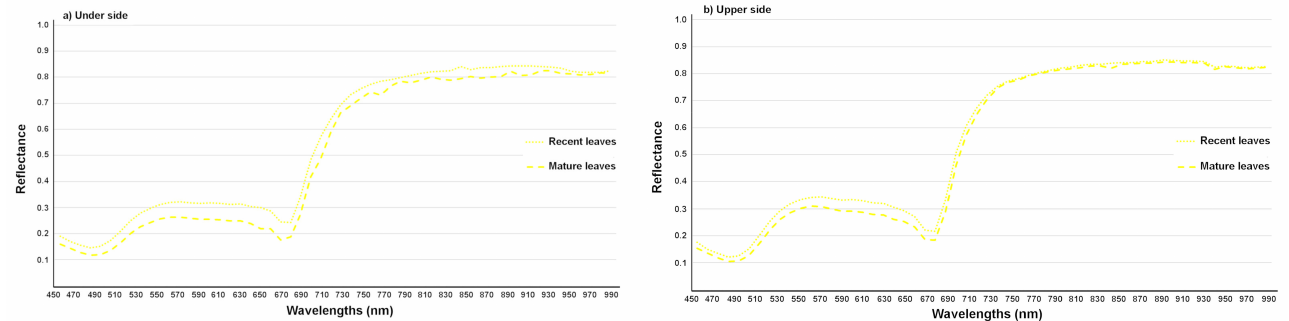
Figure 6. Mean spectra of damaged regions caused by T. urticae on ( a ) under side and ( b ) upper side of recent and mature leaves.